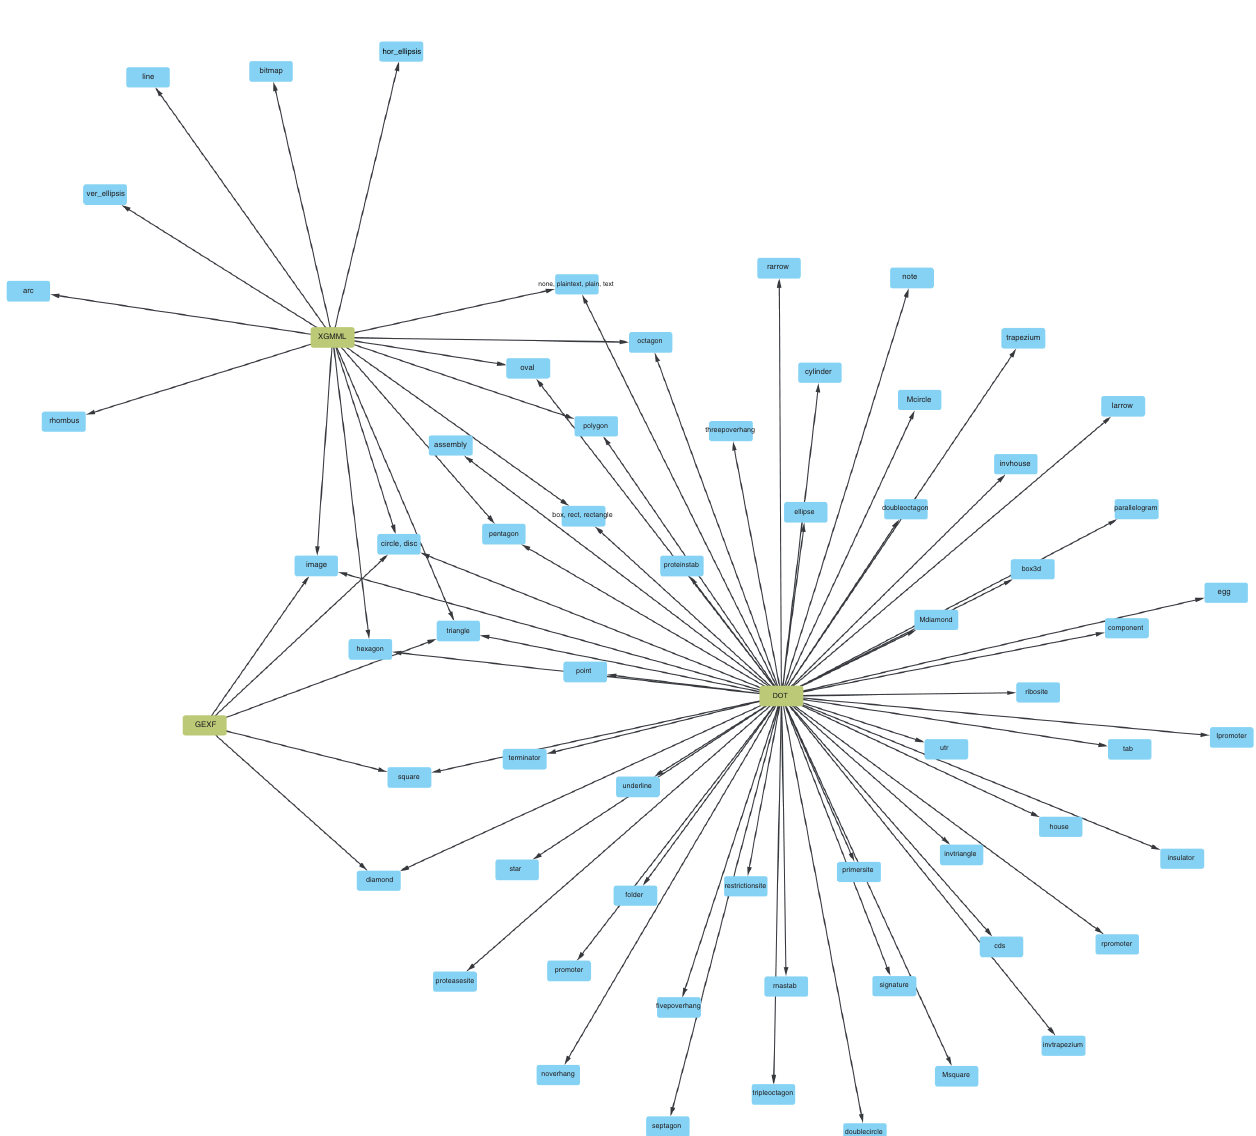
Figure 1. Graph showing which node shapes are supported by which